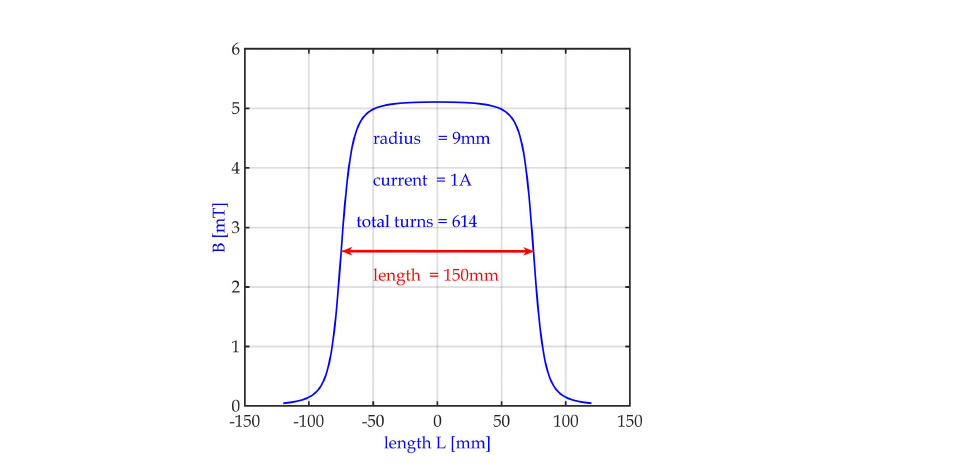
Figure 7. Calculated magnetic field in a coil, length = 150 mm, radius = 9 mm, windings = 614, current = 1 Ampere, B = 5.1 mT inside the